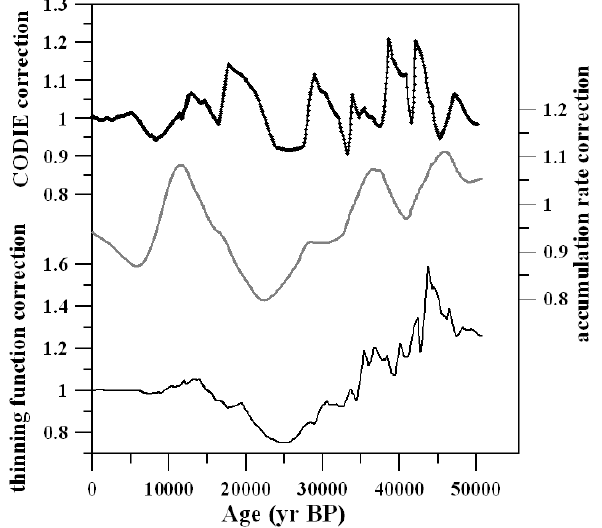
Fig. 4 : Ratio between a posteriori and a priori values of glaciological entities plotted against 1084 Fig. 4. Ratio between a posteriori and a priori values of glaciolog- the TALDICE-1 age scale: From top to bottom: CODIE (black line with symbols) 1085 ical entities plotted against the TALDICE-1 age scale: From top to accumulation rate (grey line), and thinning function (black line). 1086 bottom: CODIE (black line with symbols) accumulation rate (grey line), and thinning function (black line).